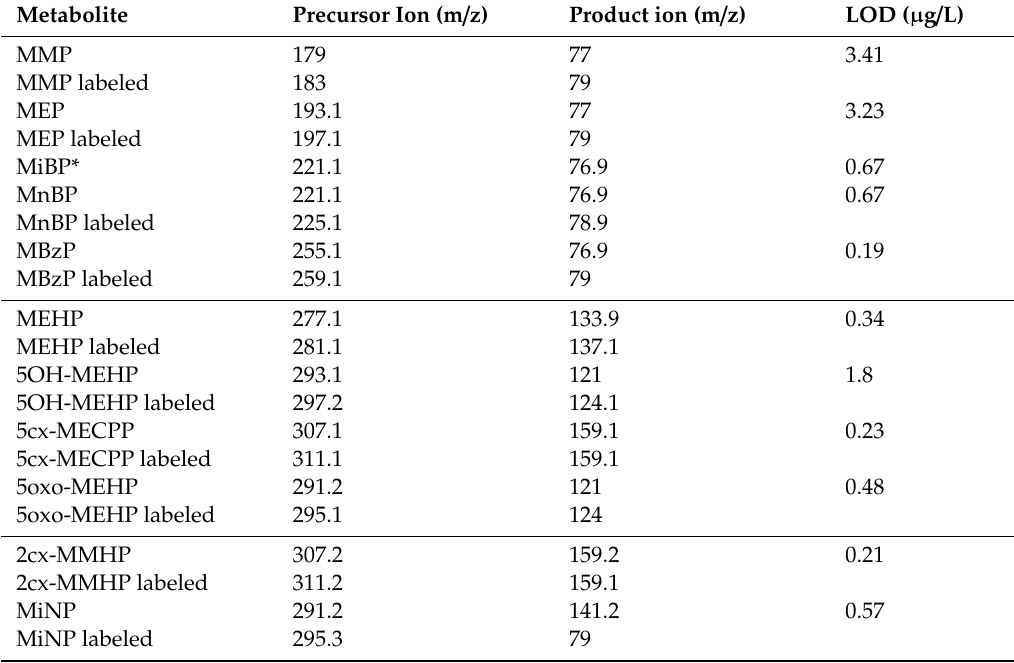
Table 1. Phthalate monoesters: chromatographic and mass spectrometric